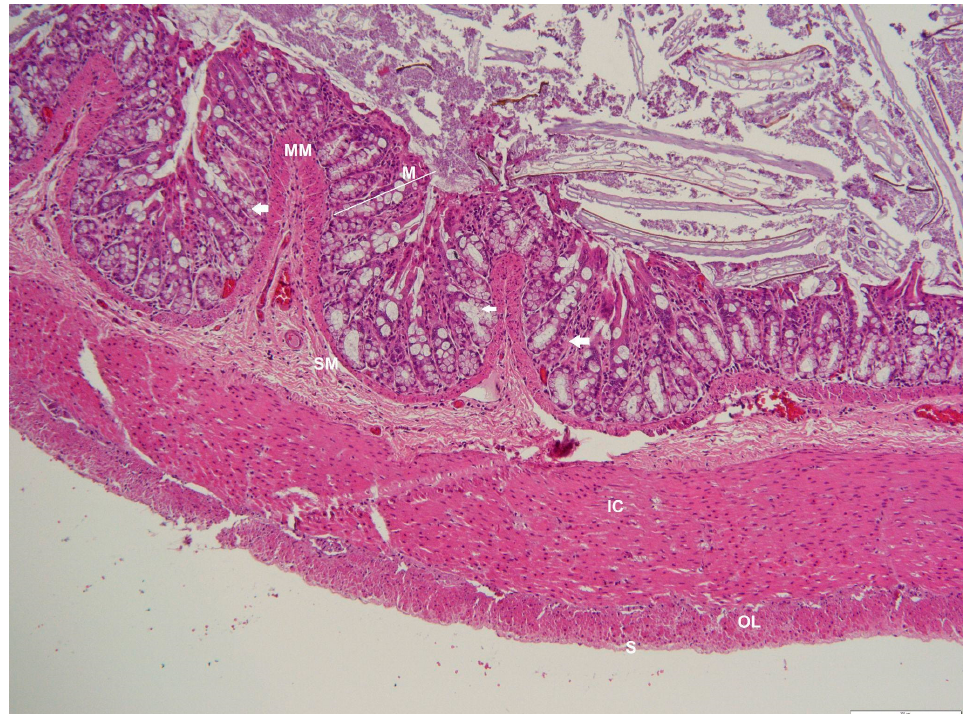
Figure 12. Photomicrograph of a transverse section through the cecum of an adult male D. leporina , showing goblet cells (arrows). H&Ex200. M—mucosa; MM—muscularis mucosa; SM—submucosa; IC—inner circular layer; OL—outer longitudinal layer; S—serosa. In the mucosa of the colon, there was a simple columnar epithelial layer with a large number of goblet cells. (Figure 13). The crypts were straight and tubular with ab- sent villi. Lymphocytic infiltration was observed in the lamina propria. Tubular, straight mucous glands were identified in the mucosa, and there were two muscle layers in the muscular layer.